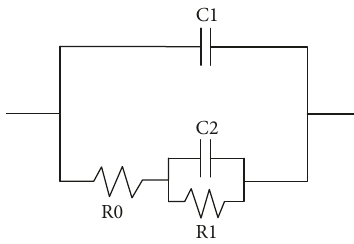
Figure 4: Equivalent circuit of the sacrificial anode